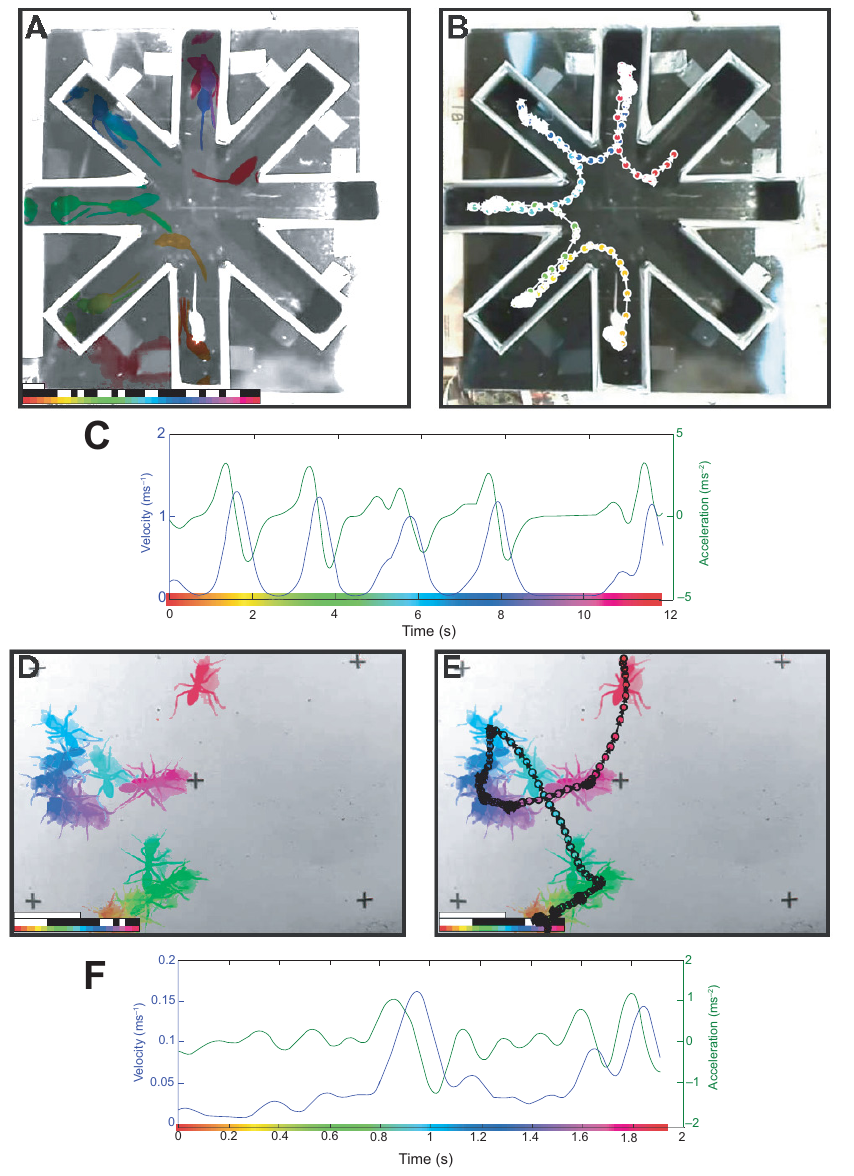
Figure 3. Application of the STL algorithm to videos of other animals. ( A ) STL image of a mouse in a radial arm maze (available from http:// www.youtube.com/watch?v=y7zQgz0vmWo, with permission of Anže Stari č (University of Ljubljana)), sampled at 3 pps. First bar in bottom left corresponds to 1 second; second bar illustrates which frames highly overlapped with adjacent frames; third bar shows time-color mapping used. ( B ) Path of same movement data as shown in panel A , overlaid on the reference frame, sampled at 30 pps. ( C ) Velocity-acceleration plot of same movement data as panels A and B . ( D ) STL image of an ant in an open environment, sampled at 10 pps (after adjusting for use of high-speed camera; available from http://www.youtube.com/watch?v=u7LaPjMtmYM with permission of Antoine Wystrach, Paul Graham, and Andrew Philippides (University of Sussex)). First bar in bottom left corresponds to 10 seconds; second bar illustrates which frames highly overlapped with adjacent frames; third bar shows time-color mapping used. ( E ) Path of same movement data as panel D , overlaid on the STL image, sampled at 100 pps. ( F ) Velocity-acceleration plot of same movement data as panels D and E